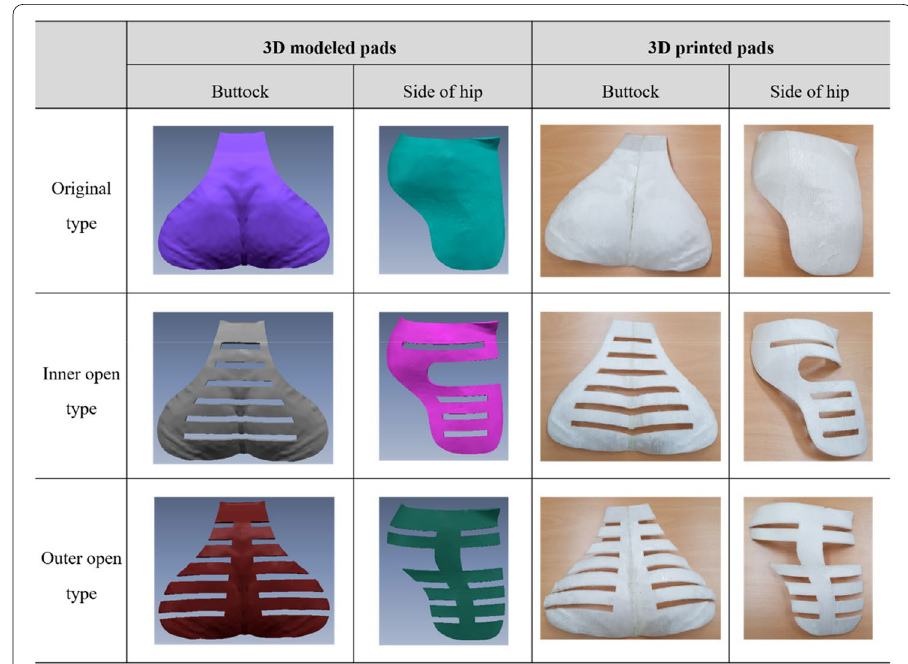
Fig. 4 Comparison of 3D modeled results and 3D printed results